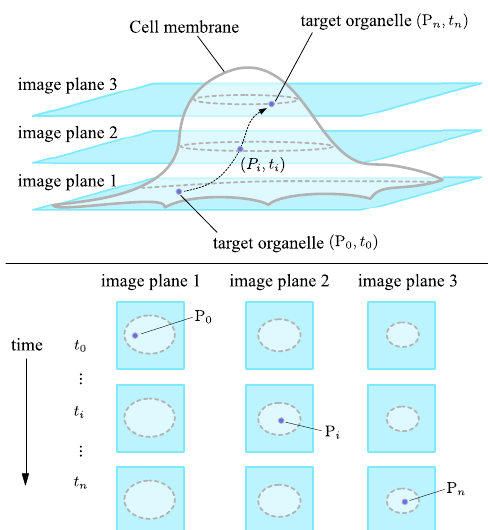
Figure 1. Sample movement of an intracellular organelle in three dimensions. In a conventional imaging microscopy system in which a single image plane is exploited, the accurate position information on the target organelle can be lost when it leaves the image plane. For example, the position of target organelle, P i at t i and P n at t n can hardly be imaged with image plane 1. P 0 ,P i and P n indicate the position information at time t 0 , t i and t n ,